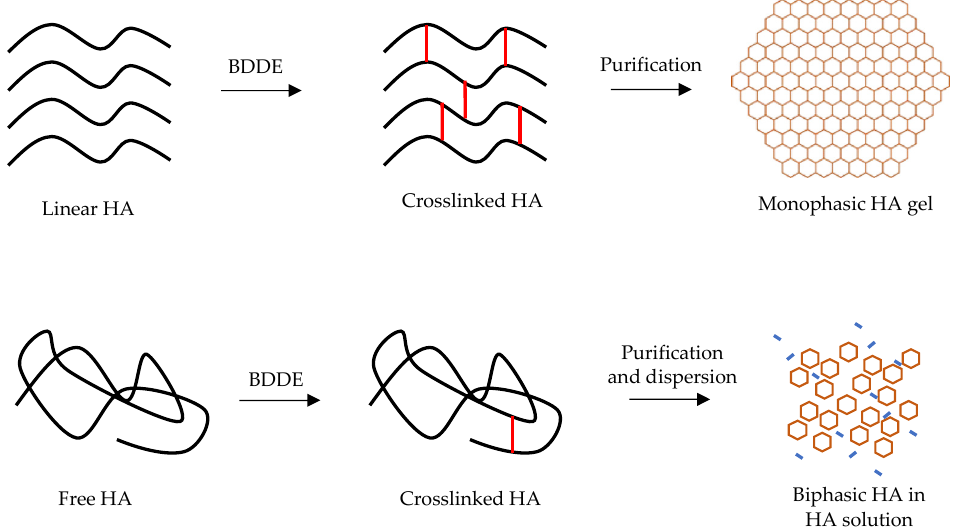
Figure 1. Monophasic vs. biphasic fillers.